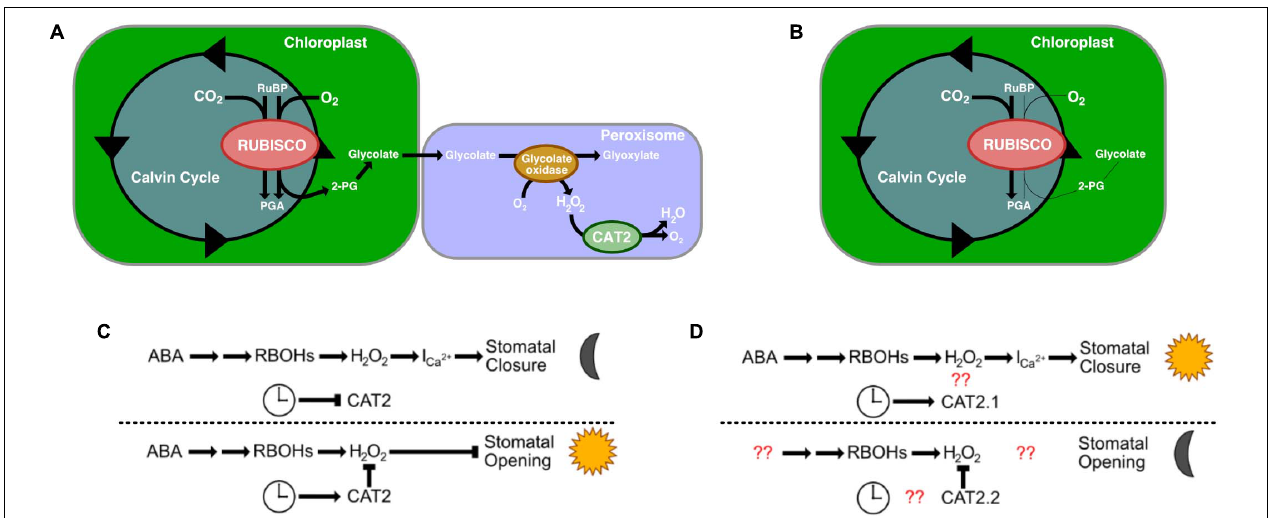
FIGURE 4 | The role of Catalase 2 (cid:48) s (CAT2) roles in C 3 plants and in CAM plants. (A) CAT2’s role in photorespiration in C 3 plants. (B) Photorespiration is reduced in CAM plants. (C) CAT2’s role in stomatal open closing (top) and opening (bottom) in C 3 plants. (D) CAT2’s predicted role in stomatal closing (top) and opening (bottom). Red question marks indict unknown interactions that warrant further investigation. RuBP, Ribulose 1,5-biphosphate; PGA, 3-phosphoglyceric acid; 2-PG, 2-phosphogylycolate; I ca2 + , Ca 2 + channels; H 2 O 2 , hydrogen peroxide; RBOH, respiratory burst